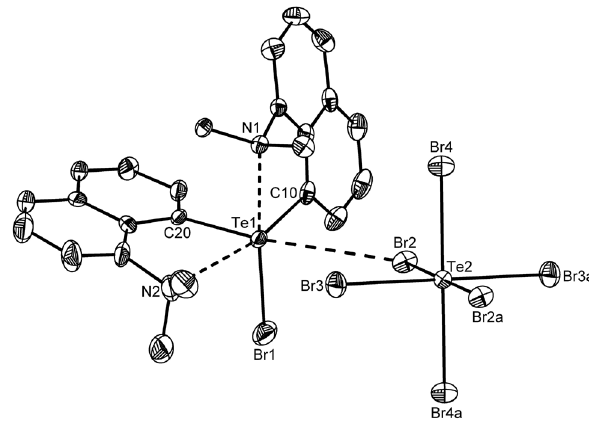
NC H ) TeBr] TeBr ( 2 ) 2 10 6 2 2 6